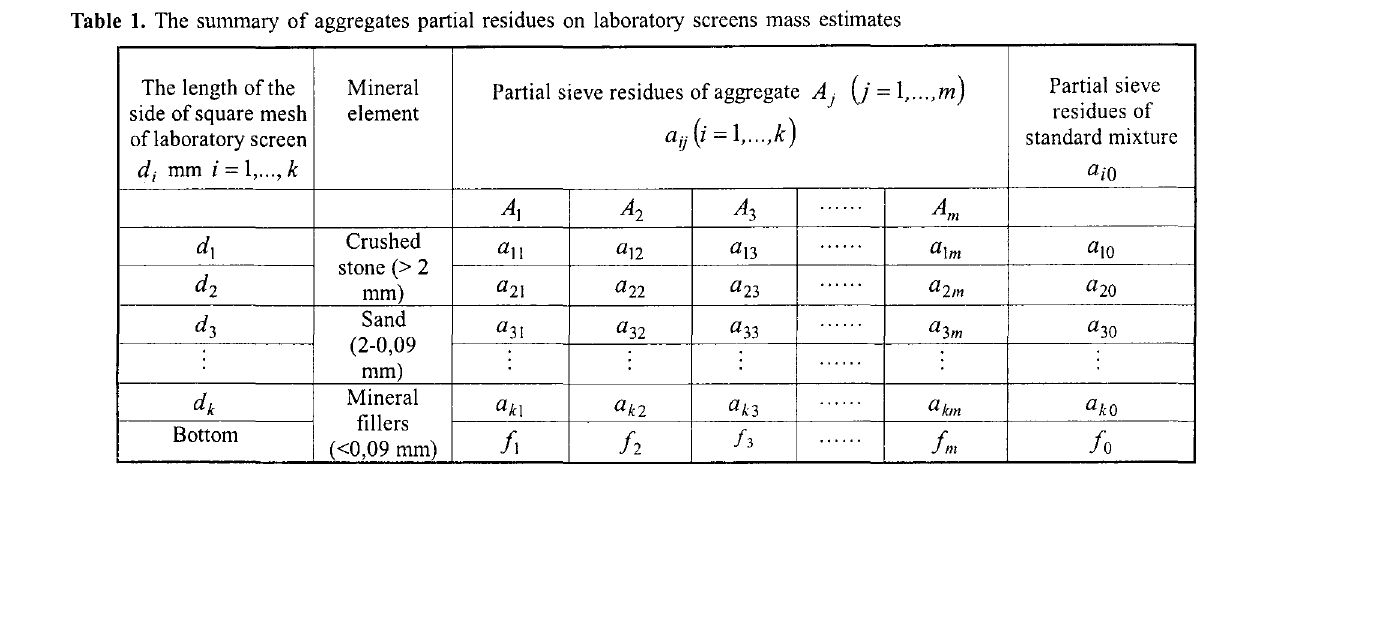
Fig 1. The circuit of technological screens of the screen of asphalt mixing plant TELTOMAT-160 and its multi section hopper, containing discretely finally dozen screened hot fractions, and also hoppers of cold RD and IF